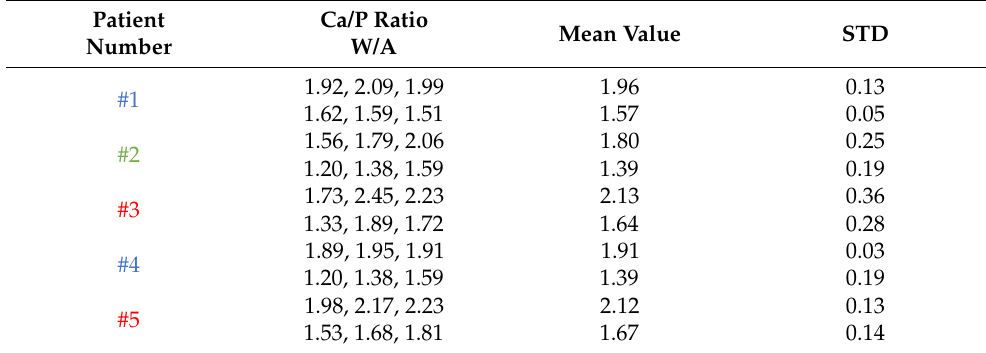
Table 4. Ca/P fraction; summarized results according EDX method (three measurements for each sample, standard deviation STD included; in green/blue are the ‘successful’ patients and in red the ones that have augmentation